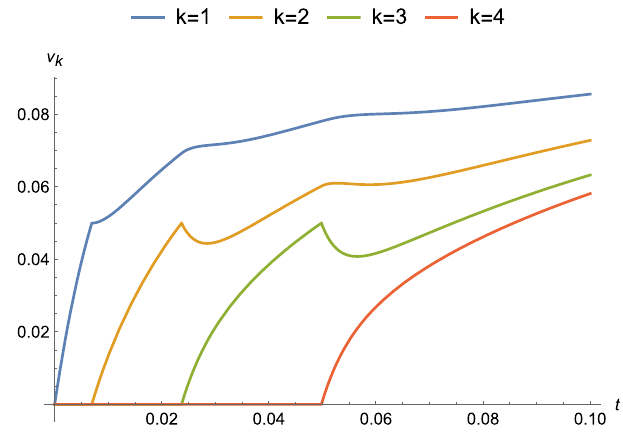
Figure 12. Complete response for parameters that approximate an axon ( α = 10 − 6 , R = 10 12 � , C = 10 − 8 F , and ν 0 ( t ) = 100 mV ) under binding regime that approximates reaction-rate limited growth with tiles in saturation and a threshold of τ = 50 mV